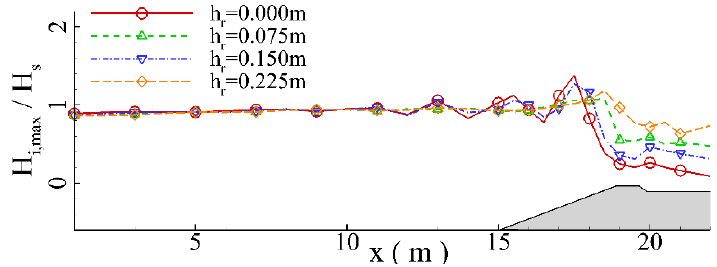
Figure 35. Local relative maximum water elevation at the reef crest versus the submergence water depth.